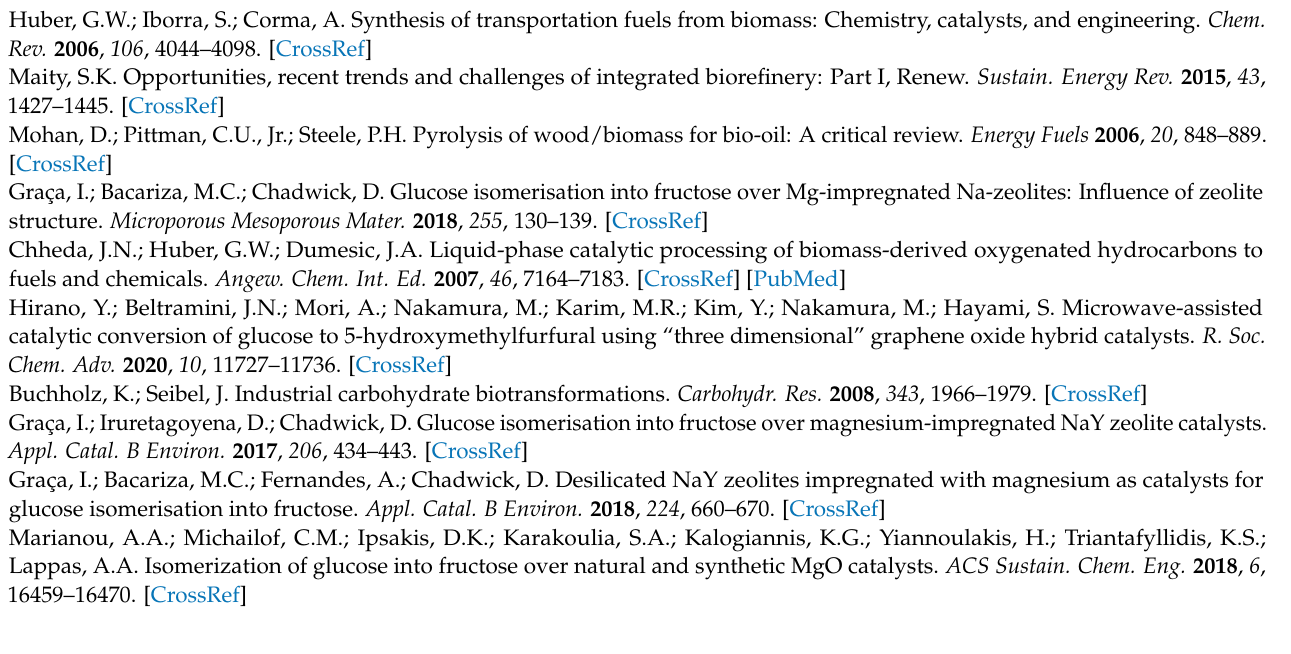
treatment (2.0 M), Figure S2: HPLC chromatogram of the products obtained from 9Mg/NaX catalyst, Figure S3: XRD patterns of spent 6Mg/NaX catalyst with each consecutive run, Table S1: Solid yield after calcination based on the weight of dried cogon grass and chemical composition determined by AAS, Table S2: Relative crystallinity and Mg leaching content of consecutive cycle